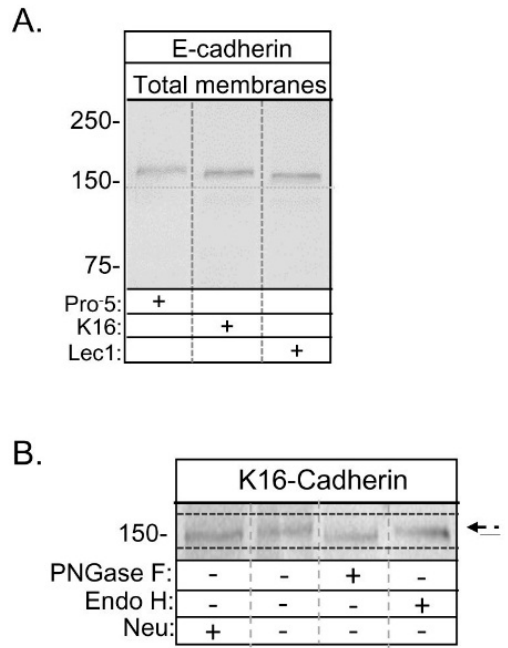
Figure 5. Electrophoretic migration of E-cadherin expressed in the various CHO cell lines. Western blots of E-cadherin glycoprotein in total membranes from transfected Pro − 5, K16, and Lec1, as denoted by the plus sign ( A ); dashed line on blot was utilized to illustrate small electrophoretic shifts for the three immunobands. Total membranes of E-cadherin transfected K16 cell line were digested (+) and undigested ( − ) with PNGase F, Endo H, and neuraminidase (neu) ( B ); dashed arrow indicates glycosylated E-cadherin and solid line represents the unglycosylated form. Solid lines below and above immunobands were employed to emphasize the small electrophoretic shifts. The numbers adjacent to the Western blots represent the Kaleidoscope markers (in kDa).